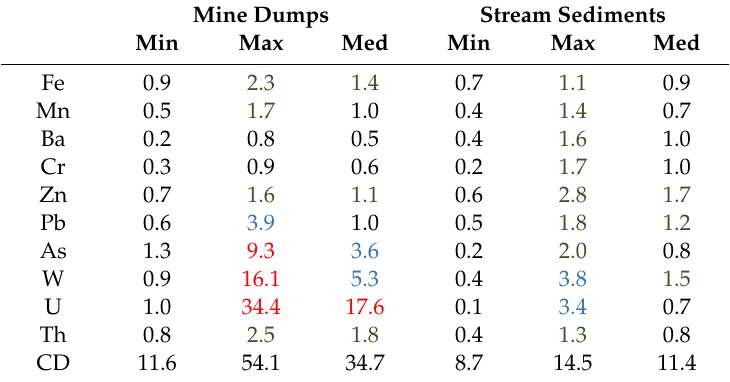
Table 3. Values of contamination factor and contamination degree of mine dumps and stream sediments from Canto Lagar. Mine Dumps Stream Sediments